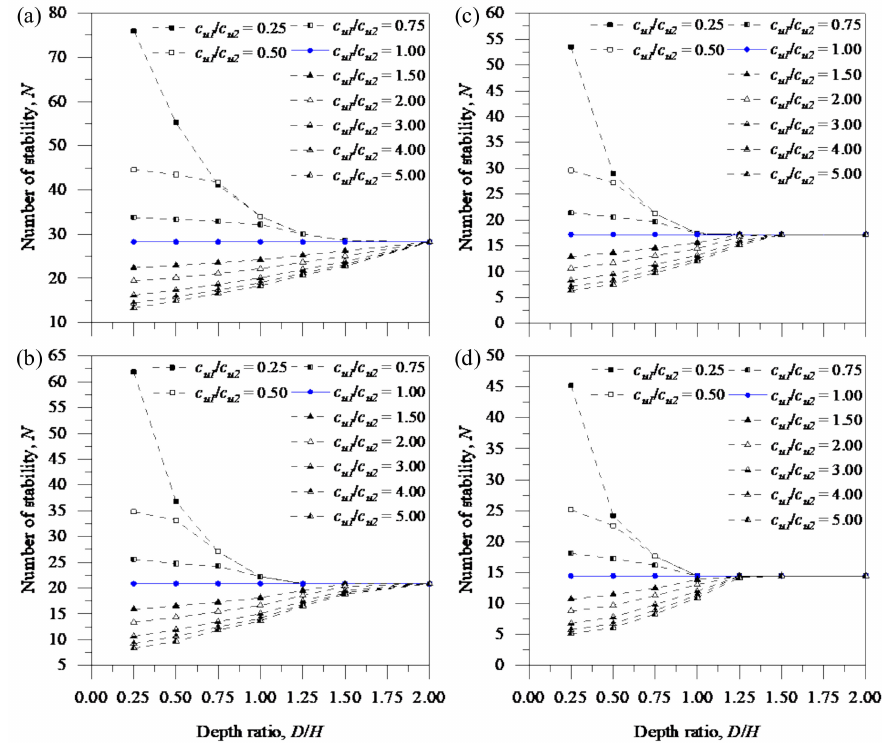
Figure 13. The e ff ect of the relative top layer thickness, where T / H = 2, H / B = 0.5 ( a ) β = 15 ◦ , ( b ) β = 30 ◦ , ( c ) β = 45 ◦ , and ( d ) β = 60 ◦